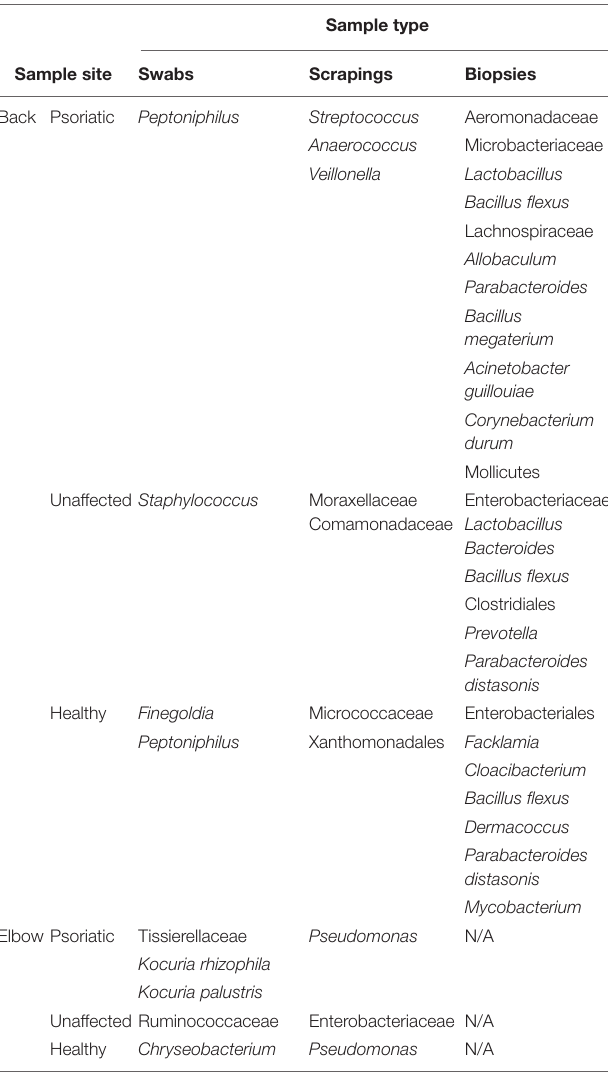
TABLE 1 | The main discriminative bacterial features related to sampling approaches. Representative bacterial biomarkers related to sampling